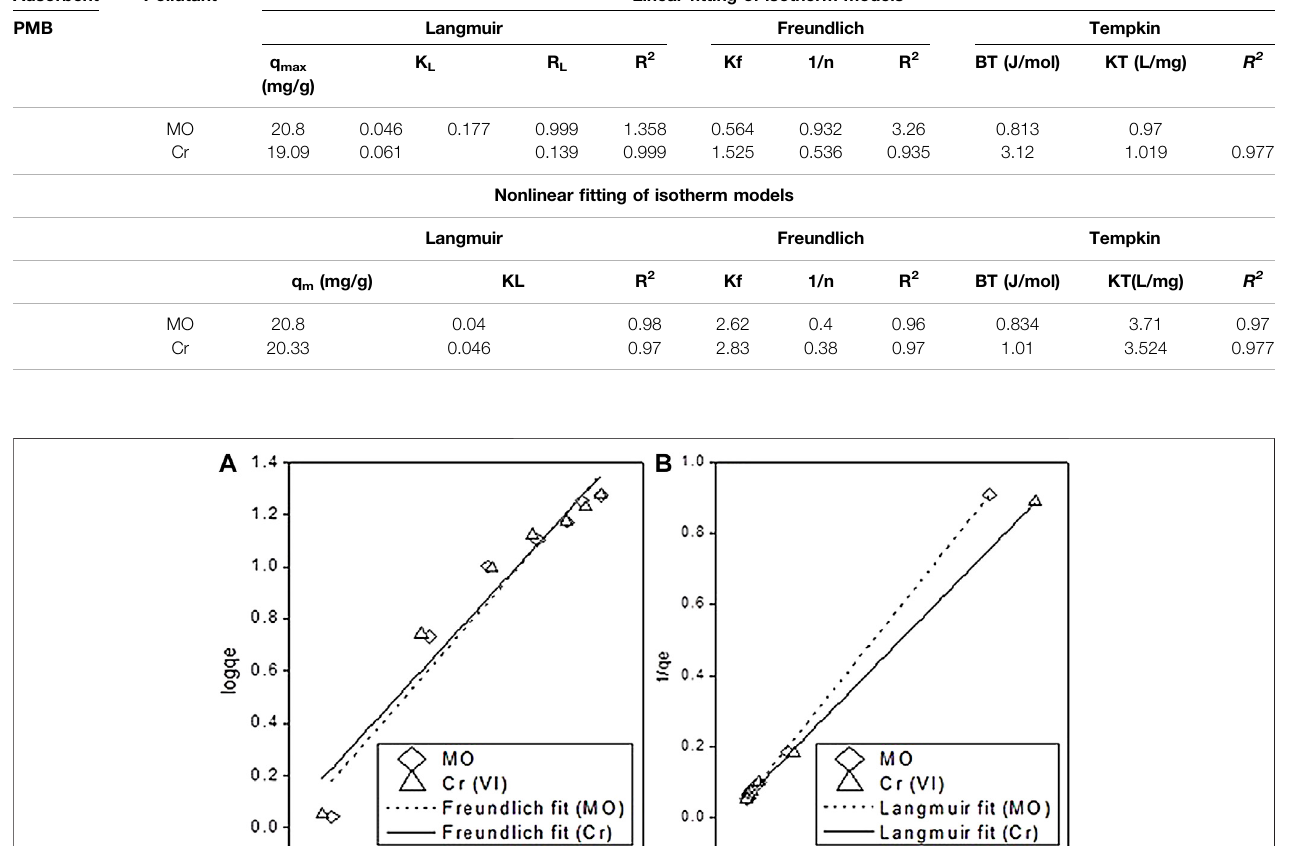
Frontiers in Environmental Science |